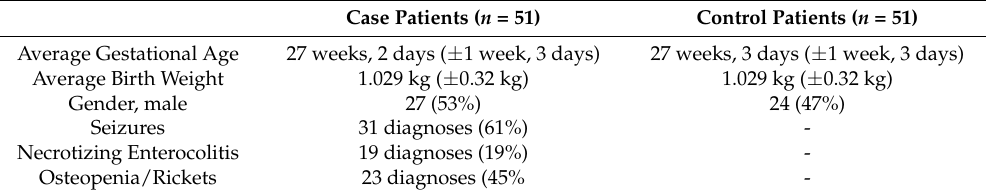
Table 2. Patient Demographic